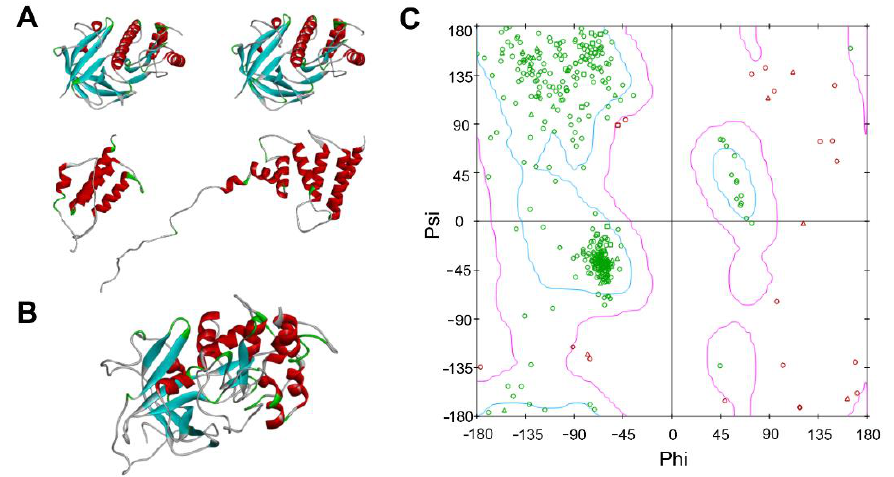
Figure 3. Homology modeling and evaluation. ( A ) The 3D structures of the template 6nx4_A, 5ks5_A, 3lkm_A, and 3pdt_A from the top left to the bottom right, respectively. ( B ) eEF2K 3D homology